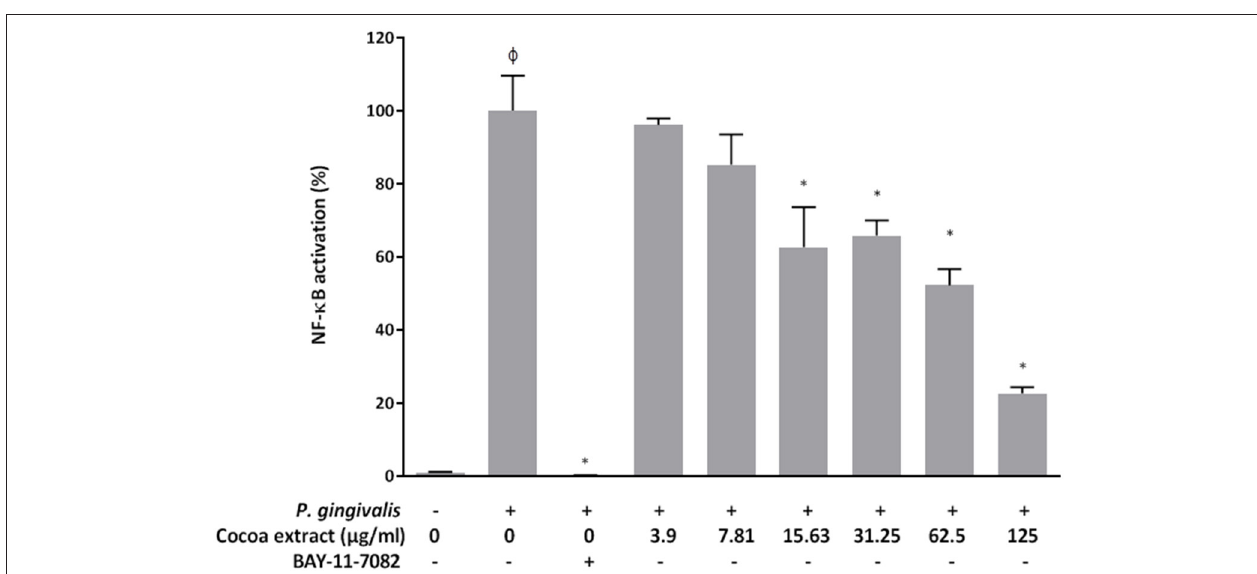
FIGURE 9 | Effect of the cocoa extract on the activation of the NF- κ B signaling pathway induced by P. gingivalis (MOI of 10 2 ) using the human monoblastic leukemia cell line U937-3x κ B-LUC. BAY-11-7082 was used as a control inhibitor. NF- κ B activation was monitored by recording luminescence after a 6-h incubation (37 ◦ C/5% CO 2 ). A value of 100% was assigned to the activation in the absence of the cocoa extract. ϕ , significant increase ( p < 0.001) compared to the control (no P. gingivalis stimulation). *significant inhibition ( p < 0.001) compared to the control (no cocoa extract + P. gingivalis stimulation).